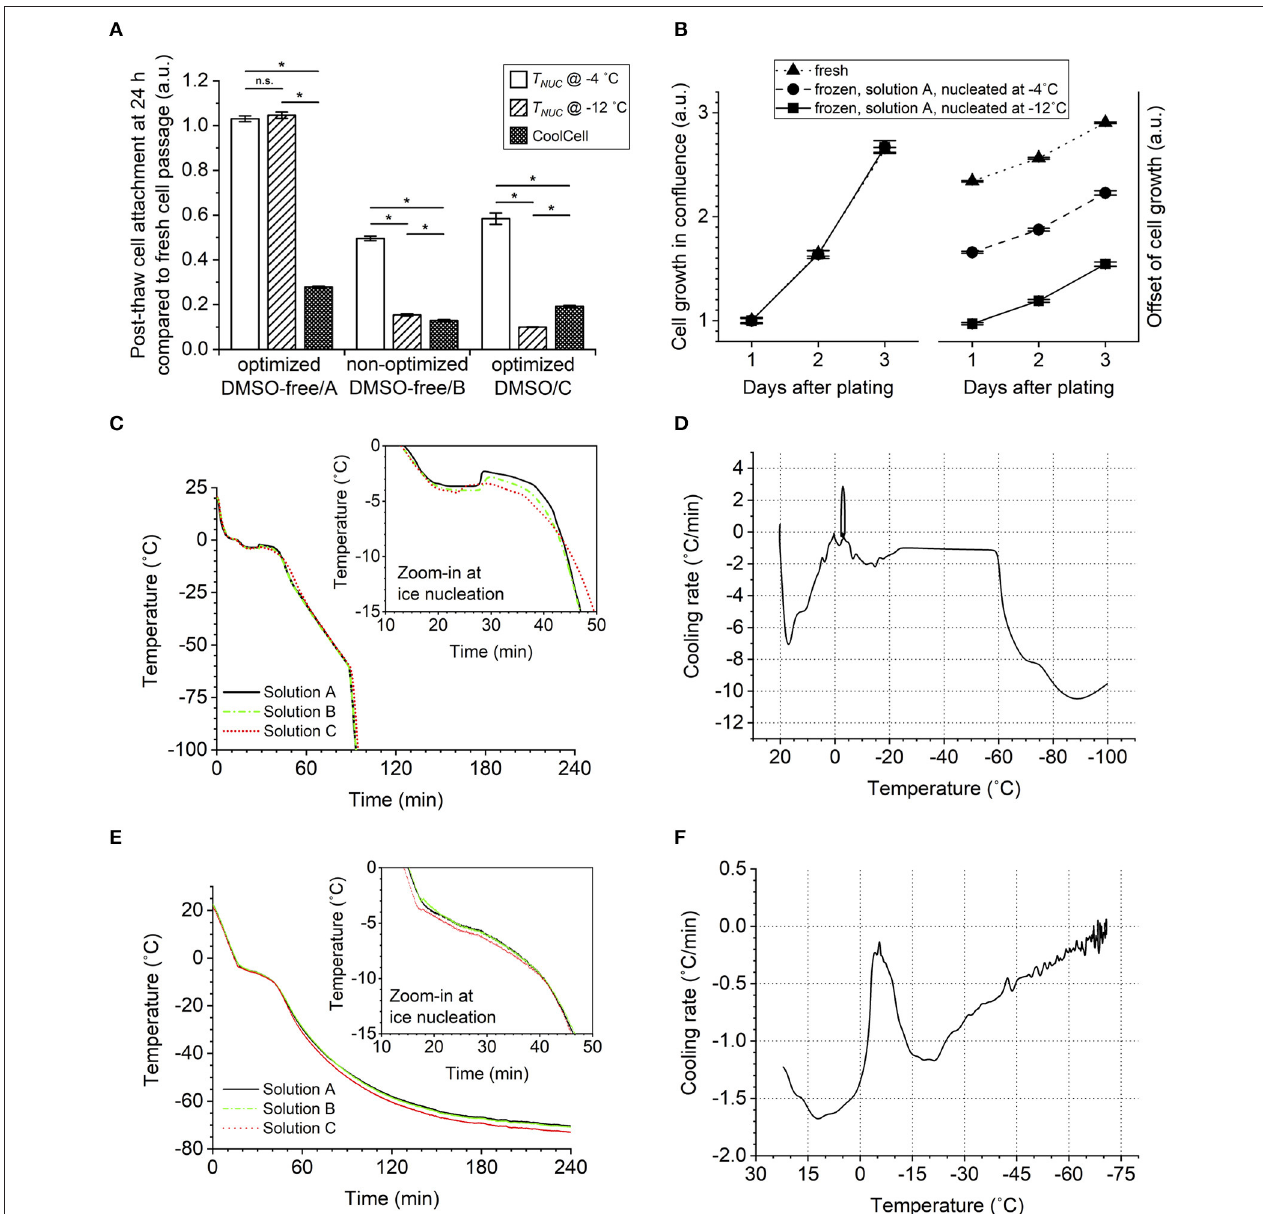
FIGURE 5 | Effect of ice nucleation temperature (undercooling) on post-thaw cell survival in conditions of different cryoprotective agent (CPA) solutions. Error bars of standard error. (A) Cell reattachment measured by calcein AM staining 24h after thawing at 1:6 split ratio, showing greater cell sensitivity to the freezing condition when using the non-optimized dimethyl sulfoxide (DMSO)-free or optimized DMSO solution than the optimized DMSO-free solution. ANOVA with Bonferroni correction performed for comparison. n.s. p > 0.05; * p < 0.05. Sample size of 18 (three independent experiments of six) biological replicates. (B) Cell growth in terms of culture confluence monitored for 3 days after thawing or passaging at 1:6 split ratio, showing normal growth rate of cryopreserved cells not affected by the ice nucleation temperature ( T NUC ). Sample size of six biological replicates. (C) Sample internal temperature recorded over the course of controlled-rate freezing with ice nucleation induced manually at − 4 ◦ C. (D) First derivative of (C) plotted against the corresponding sample internal temperature. (E) Sample internal temperature recorded over the course of passive freezing in CoolCell with spontaneous ice nucleation. (F) First derivative of (E) plotted against the corresponding sample internal temperature.